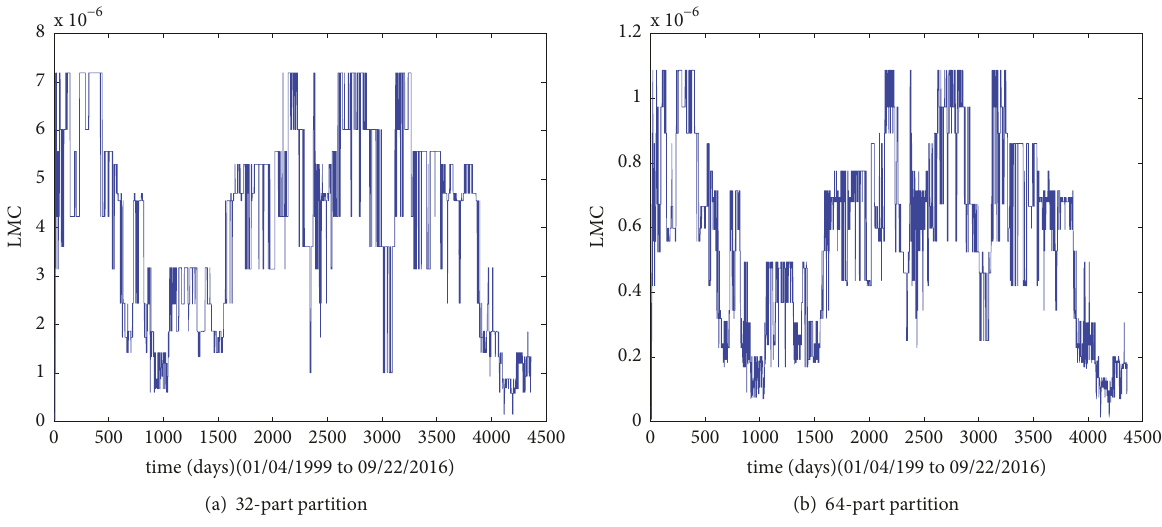
Figure 8: Temporal evolution of LMC